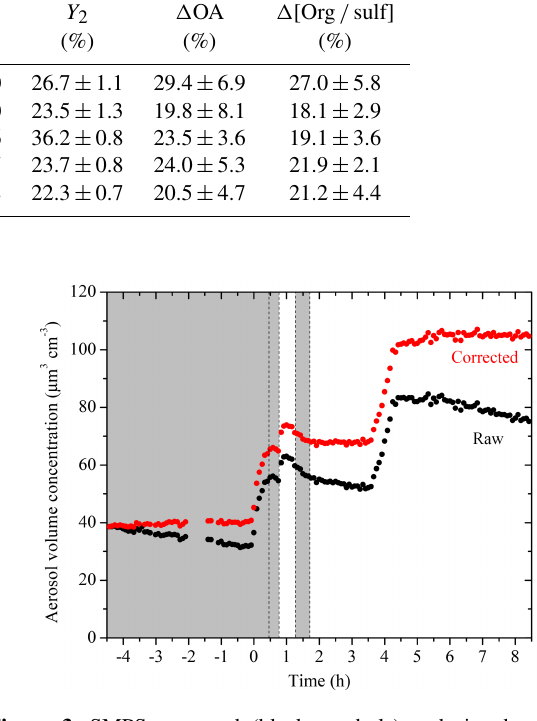
Figure 3. SMPS-measured (black symbols) and size-dependent particle-wall-loss-corrected (red symbols) aerosol volume concen- tration evolution during a typical experiment (Exp. 1). Ozone was added into the chamber at time zero to initiate α -pinene ozonolysis. The shaded areas indicate that the chamber was dark. The dashed lines mark the beginning and the end of the two times HONO were added. An amount of 5gL − 1 of ammonium sulfate particles was injected into the chamber at t = 3.5h. Data were not recorded from t =− 2 to −